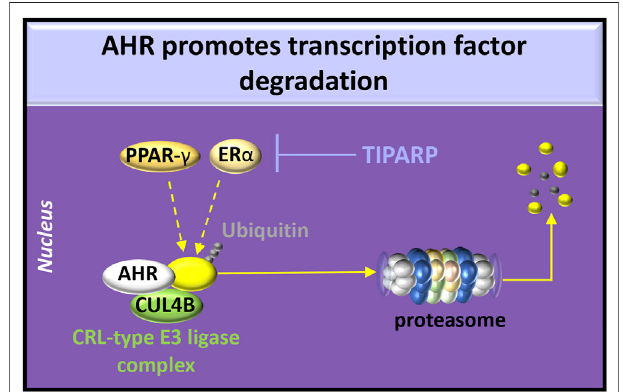
FIGURE 4 | AHR degradative functions. AHR participates in the cullin/ RING ubiquitin ligase (CRL-type E3 ligase) complex involving